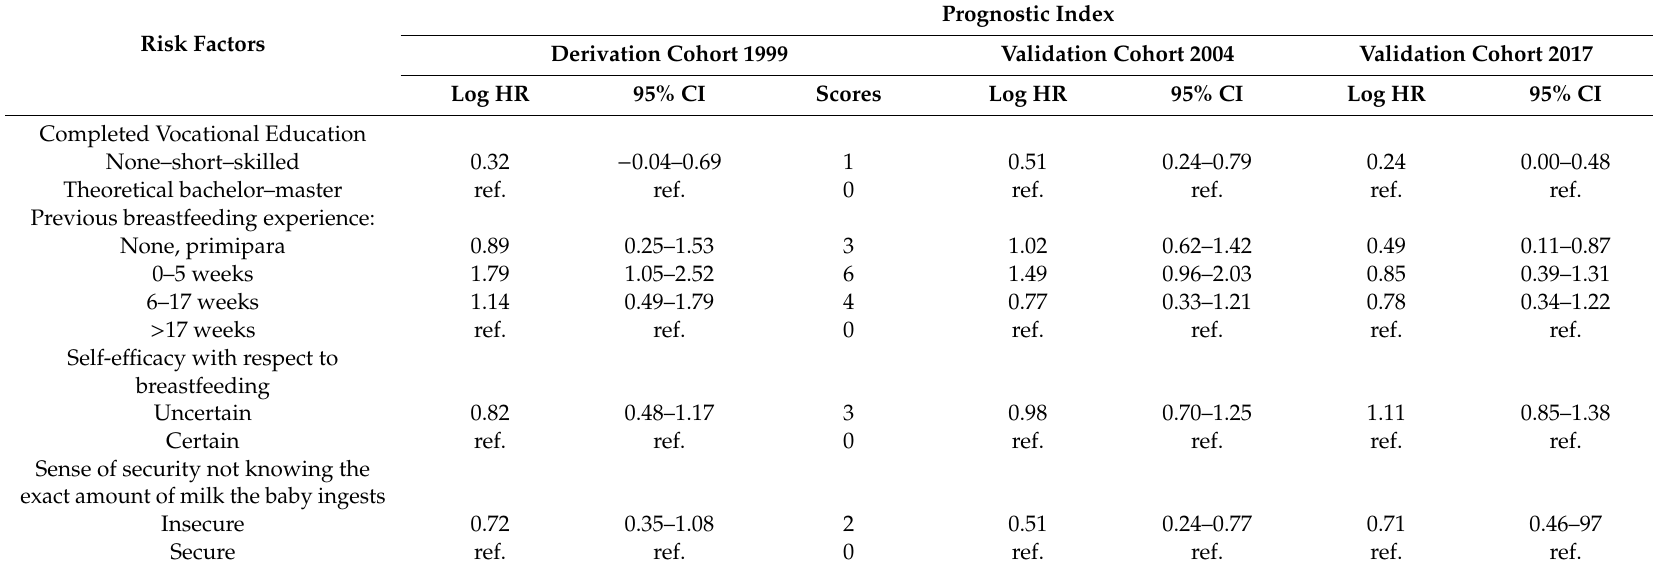
Table 2. Risk factors associated with breastfeeding cessation in the first 17 weeks after